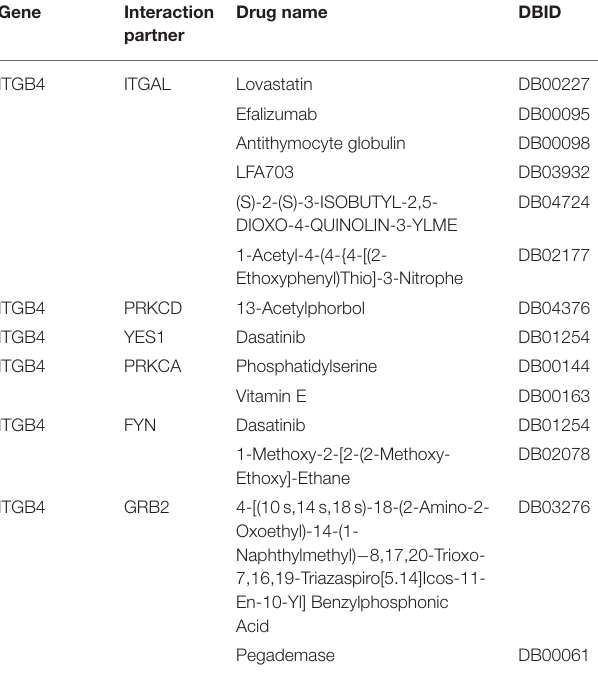
TABLE 7 | Information for available drugs targeted ITGA3/B4 and interaction